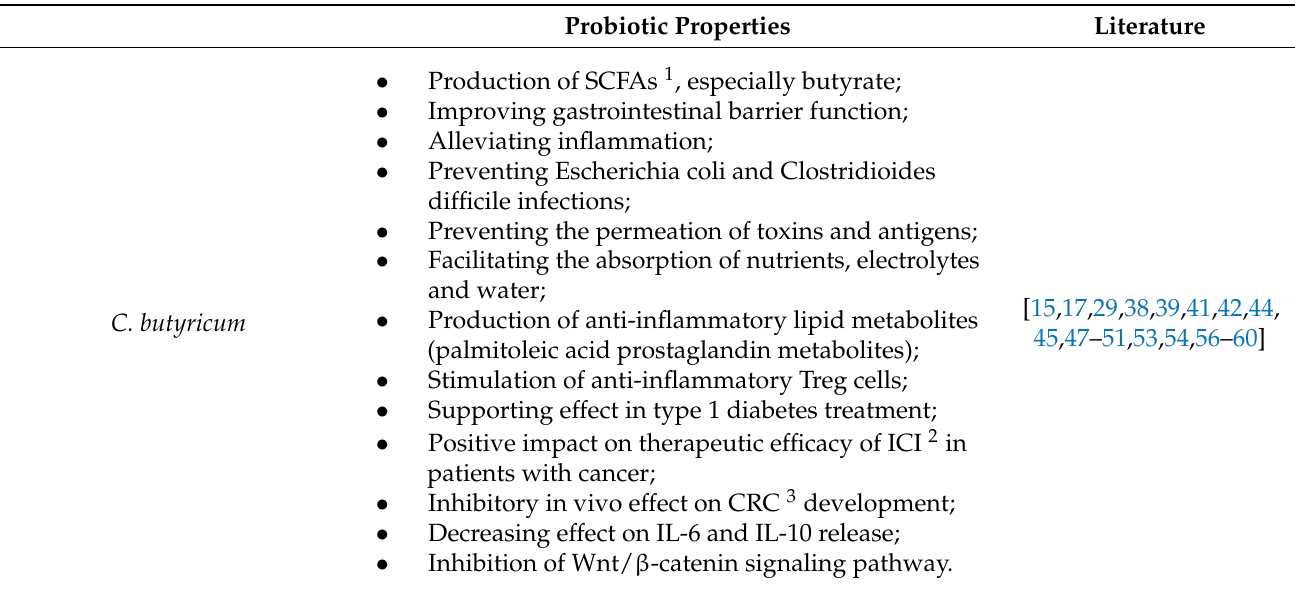
Table 2. Probiotic properties of non-pathogenic Clostridium butyricum